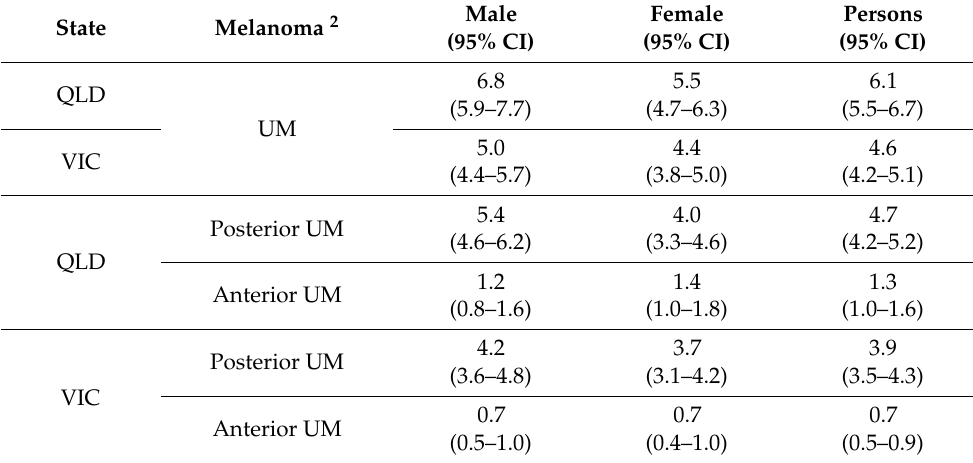
Table 2. ASR 1 of UM in QLD and VIC from 2001 to